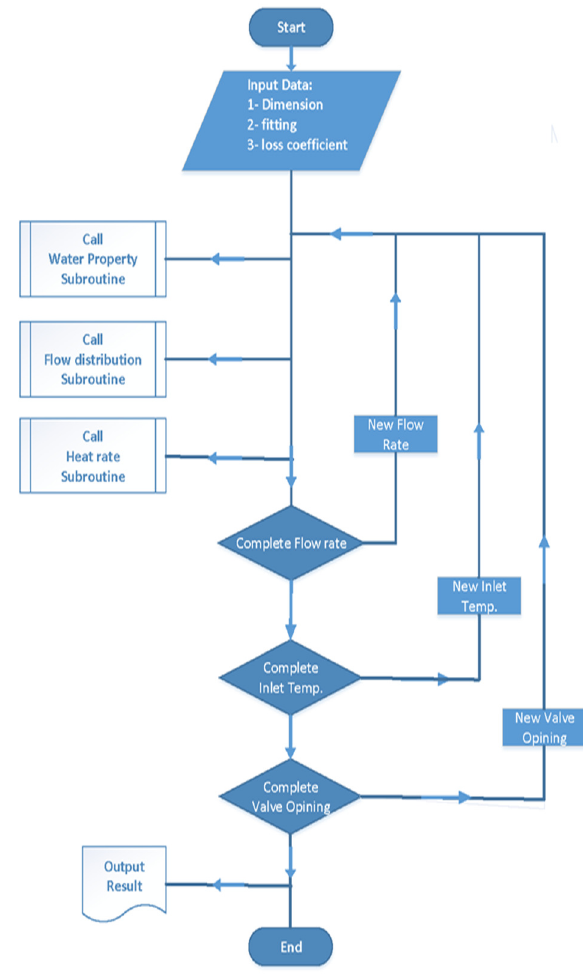
Fig. 2. Flow chart of the water distribution